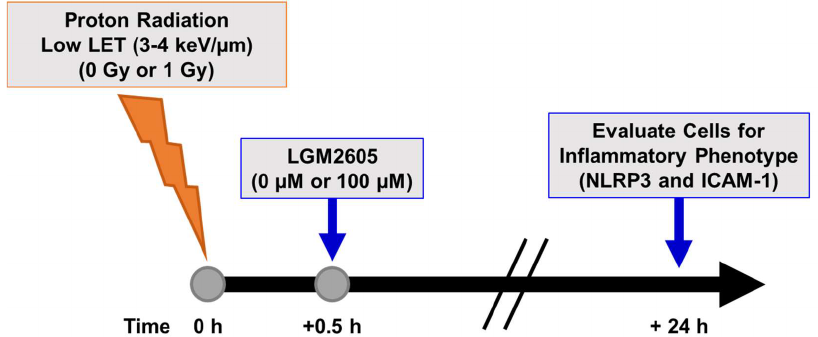
treated with 0 µ M LGM2605 (*** p <